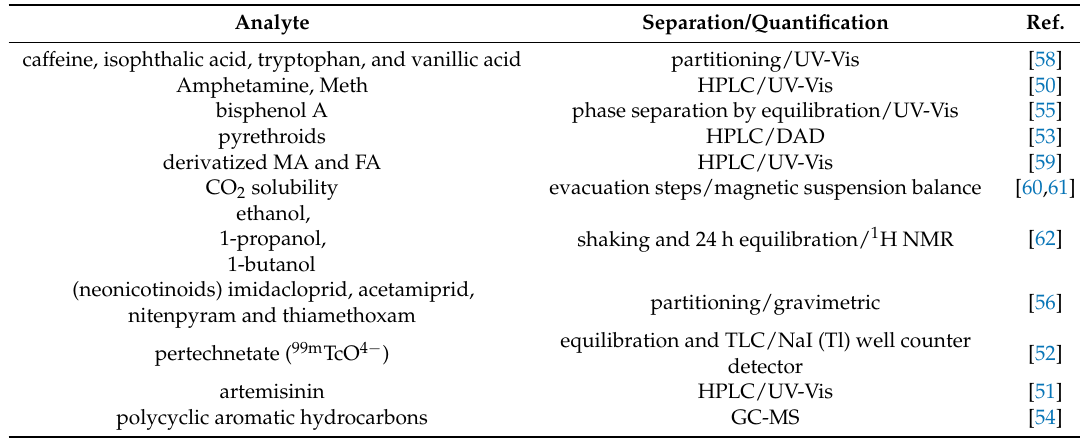
Table 3. Applications of HDES in